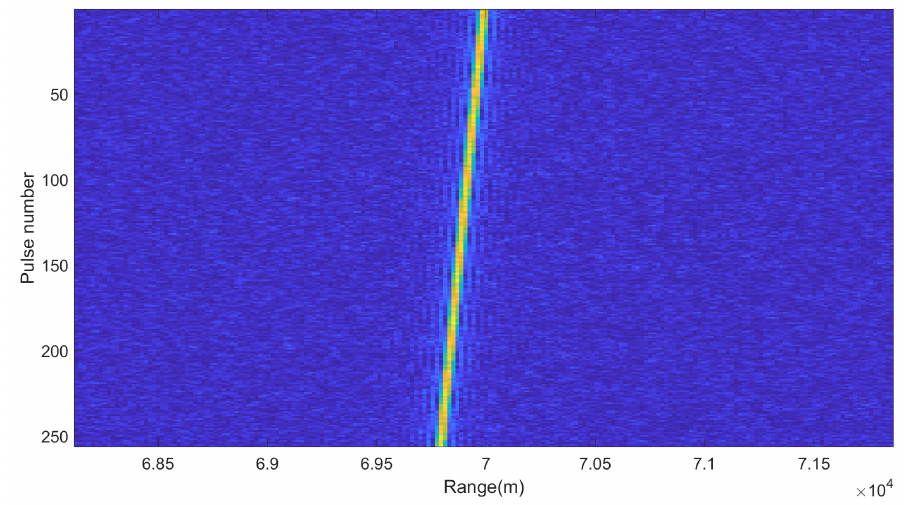
Figure 4. Range-time map after pulse